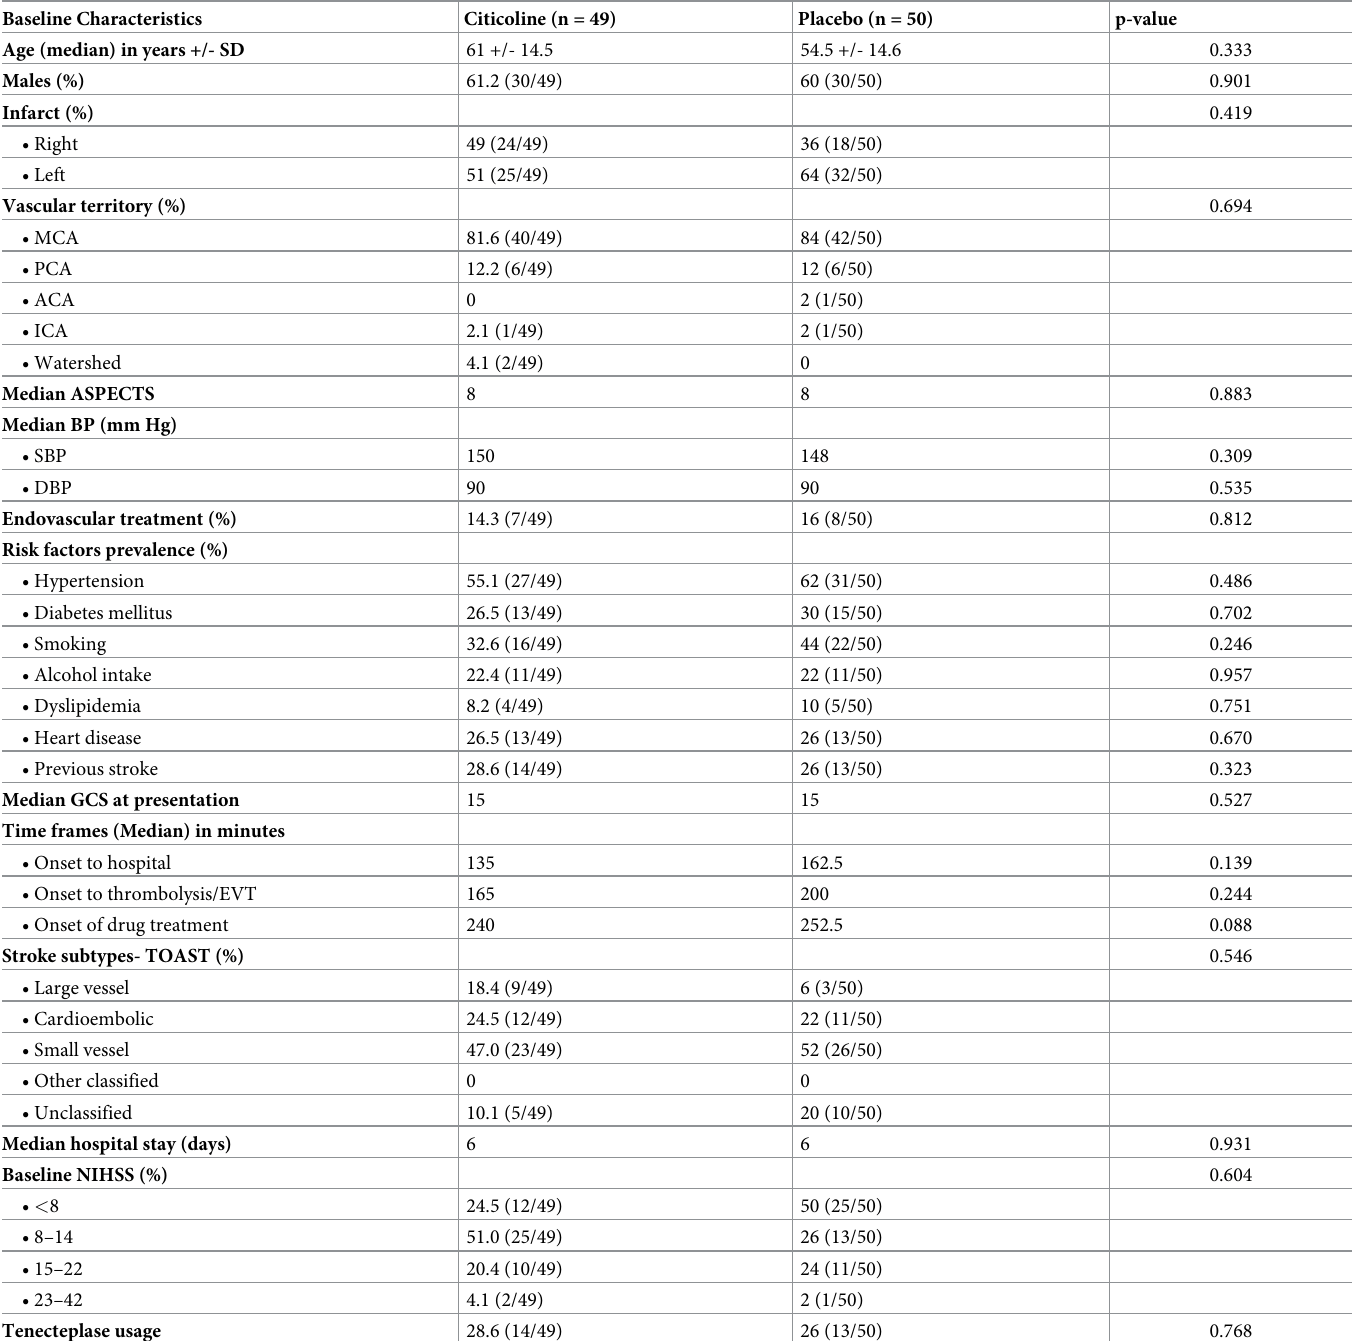
Table 1. Baseline